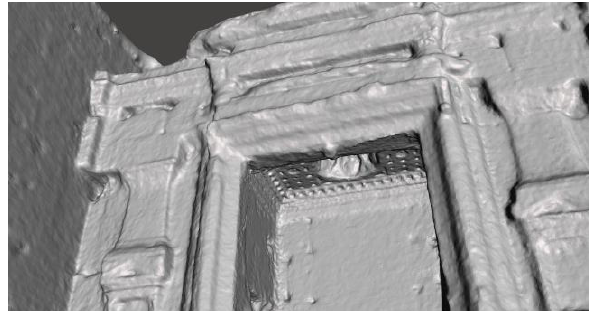
Figure 14: Detail view of the produced mesh for a part of the northern chamber.